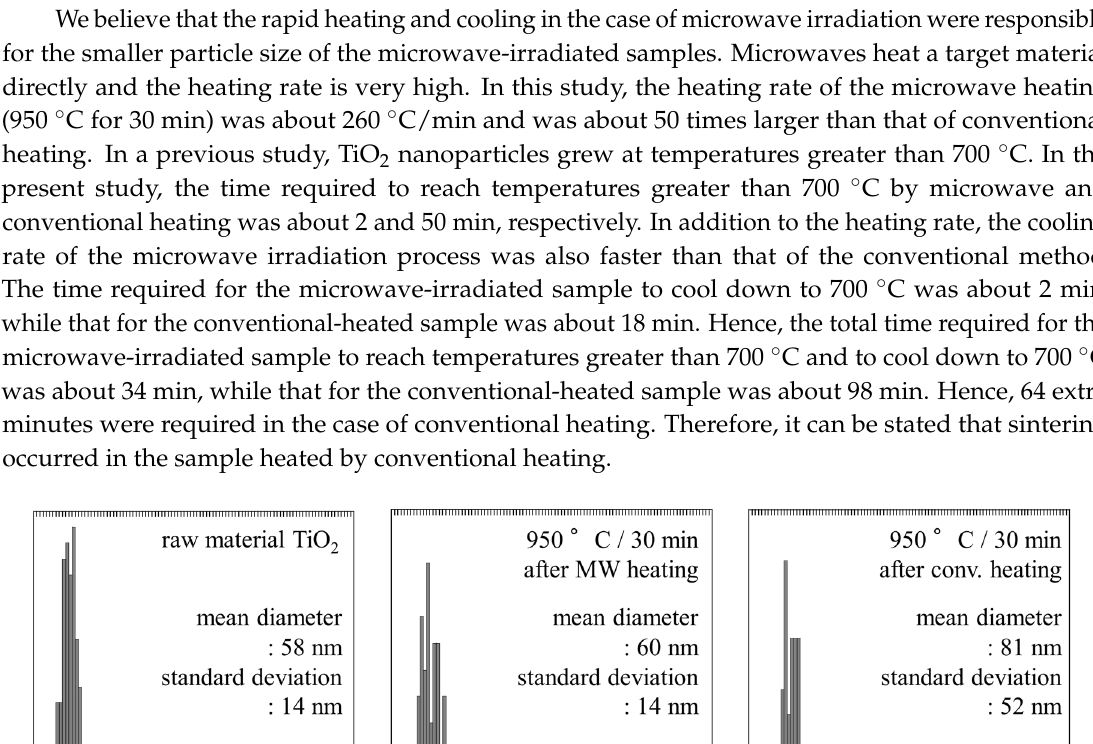
Figure 5. Histograms of particle diameter of the TiO 2 raw material and samples heated by microwave irradiation and conventional heating.